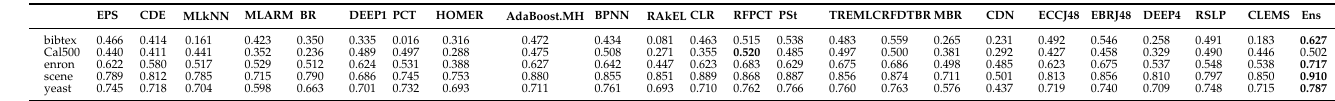
Table 8. Comparisons with results reported in a recent survey [71] using average precision as the performance indicator. Bold highlights superior performance.